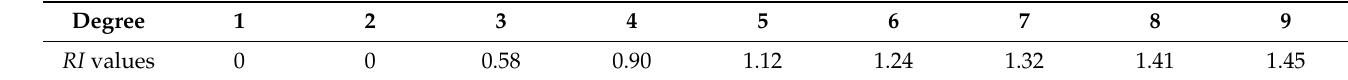
Table 6. Value of average random consistency index.